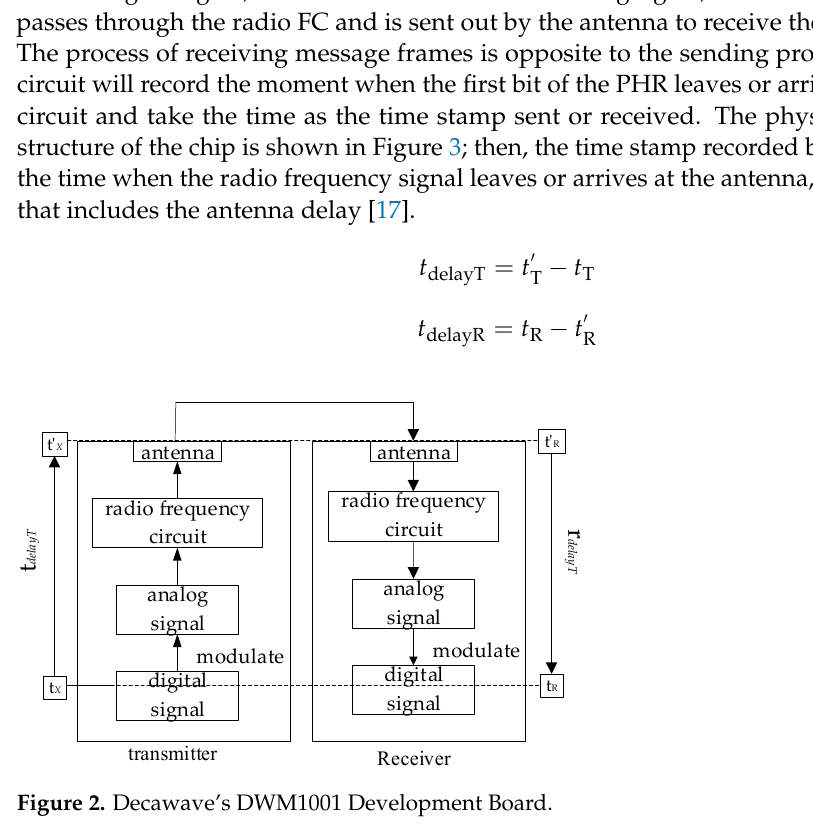
Figure 3. The frame structure of the physical layer.